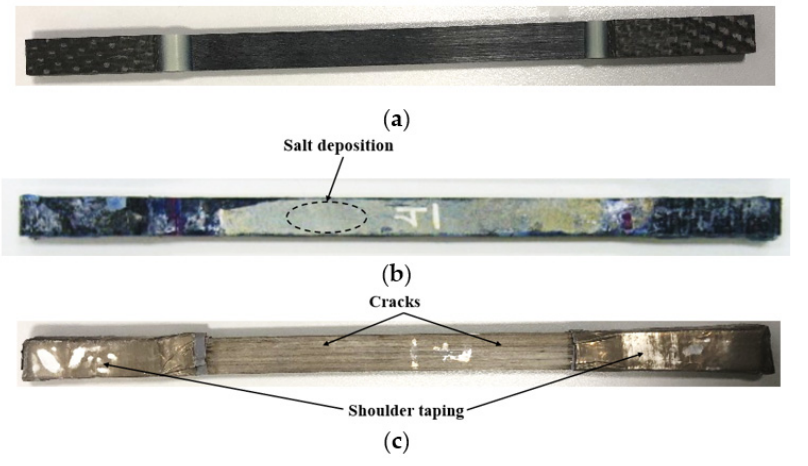
Figure 2. E-glass/epoxy specimen conditioned at various temperatures in seawater ( a ) Control sample, ( b ) 65 °C and ( c ) 90 °C.